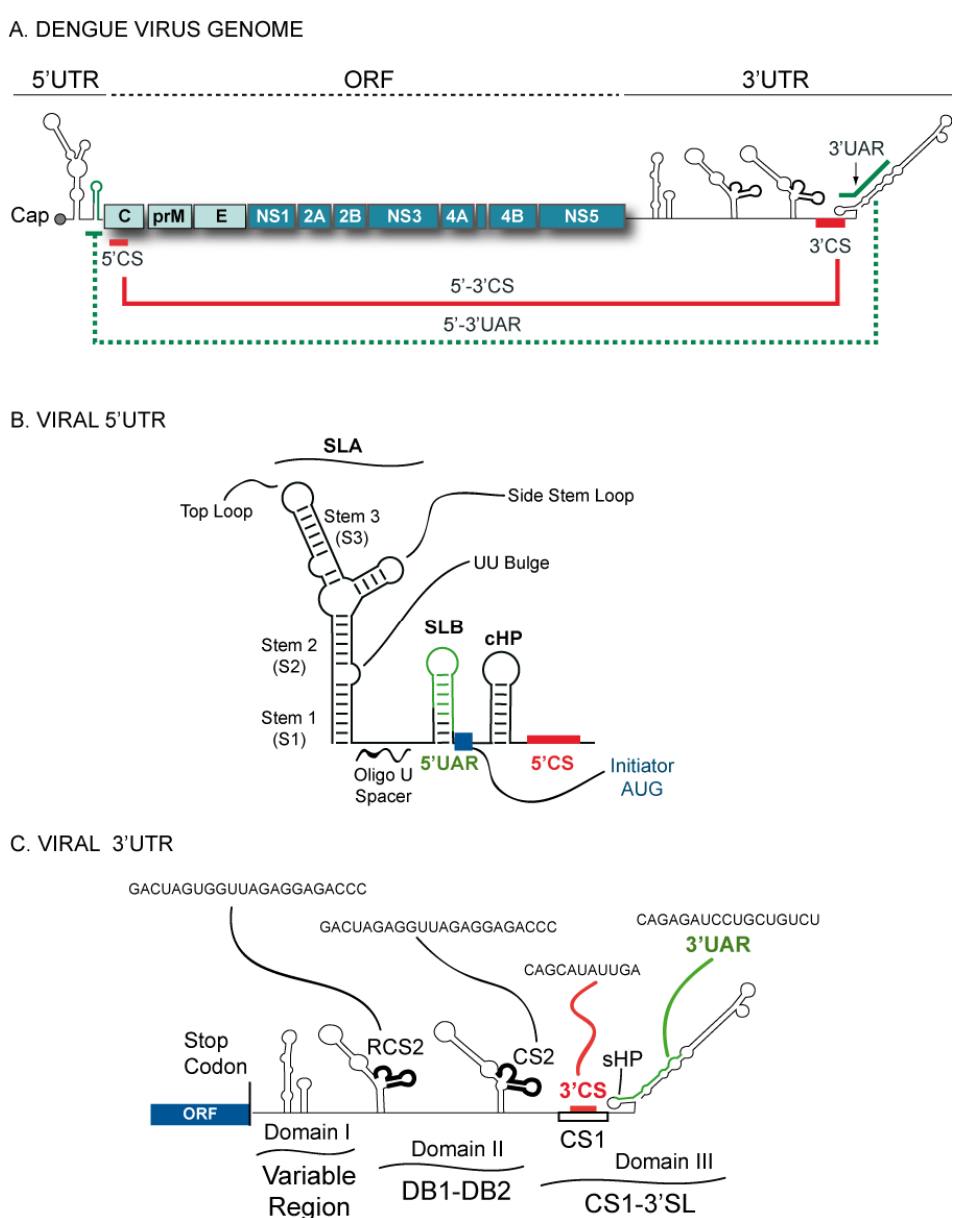
Figure 1. Schematic representation of the Dengue virus (DENV) genome. ( a ) The viral 5' and 3' untranslated regions (UTRs) and the open reading frame indicating structural proteins (C-prM-E) and non-structural proteins (NS1-NS2AB-NS3-NS4AB-NS5). The location of the complementary sequences 5'-3'CS and 5'-3'UAR are also indicated by solid and dashed lines, respectively. ( b ) Predicted secondary structure of the 5' terminal region of the DENV genome. Structural elements located at the 5' end: stem loop A (SLA), stem loop B (SLB), oligo(U) track spacer, translation initiator AUG, capsid region hairpin (cHP), and the 5'CS element. ( c ) Schematic representation of predicted RNA elements at the 3'UTR of the DENV genome. The predicted secondary structures of the three defined domains are indicated: domain I (variable region, VR), domain II (dumbbell structures, DB1 and DB2), and domain III (conserved sequence CS1 and 3'SL). In addition, the location and sequence of each of the conserved elements corresponding to RCS2, CS2, 3'CS, and 3'UAR are